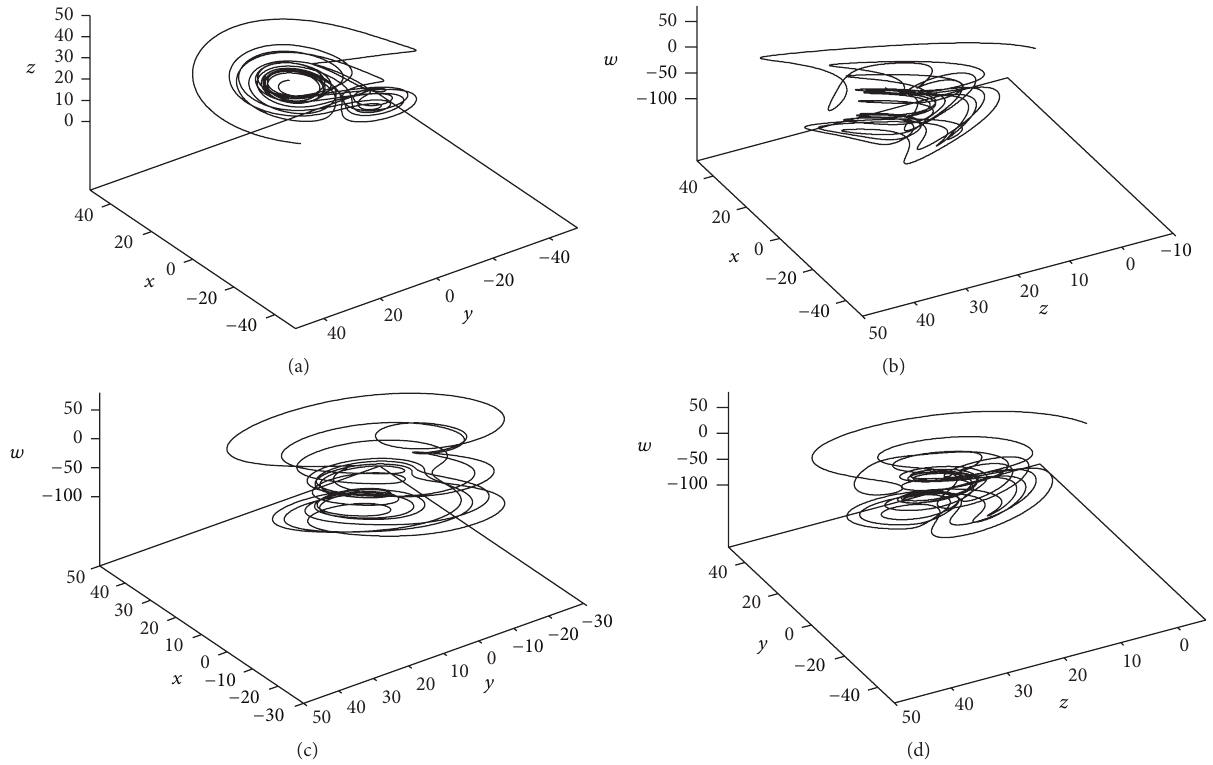
Figure 6: Phase portraits using 15-term MHPM on Δ𝑡 = 0.001 of Case 2 hyperchaotic L¨u